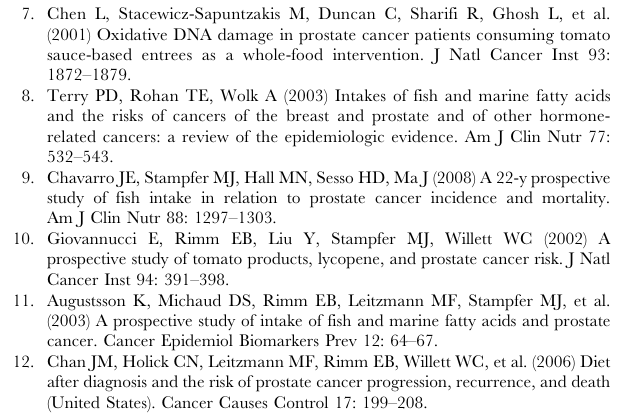
Figure S1 Samples were hybridized to 7 different batches of printed cDNA microarrays ( # 11, 12, 14, 17, 18, 19 and 20). Print run effect was controlled by fitting a linear model with log2 ratio as response and batch effect as explanatory variable and using the residuals from the fit for further analyses. Table S1 Differentially expressed genes (unadjusted p-value # 0.05) in morphologically normal prostate from men with high